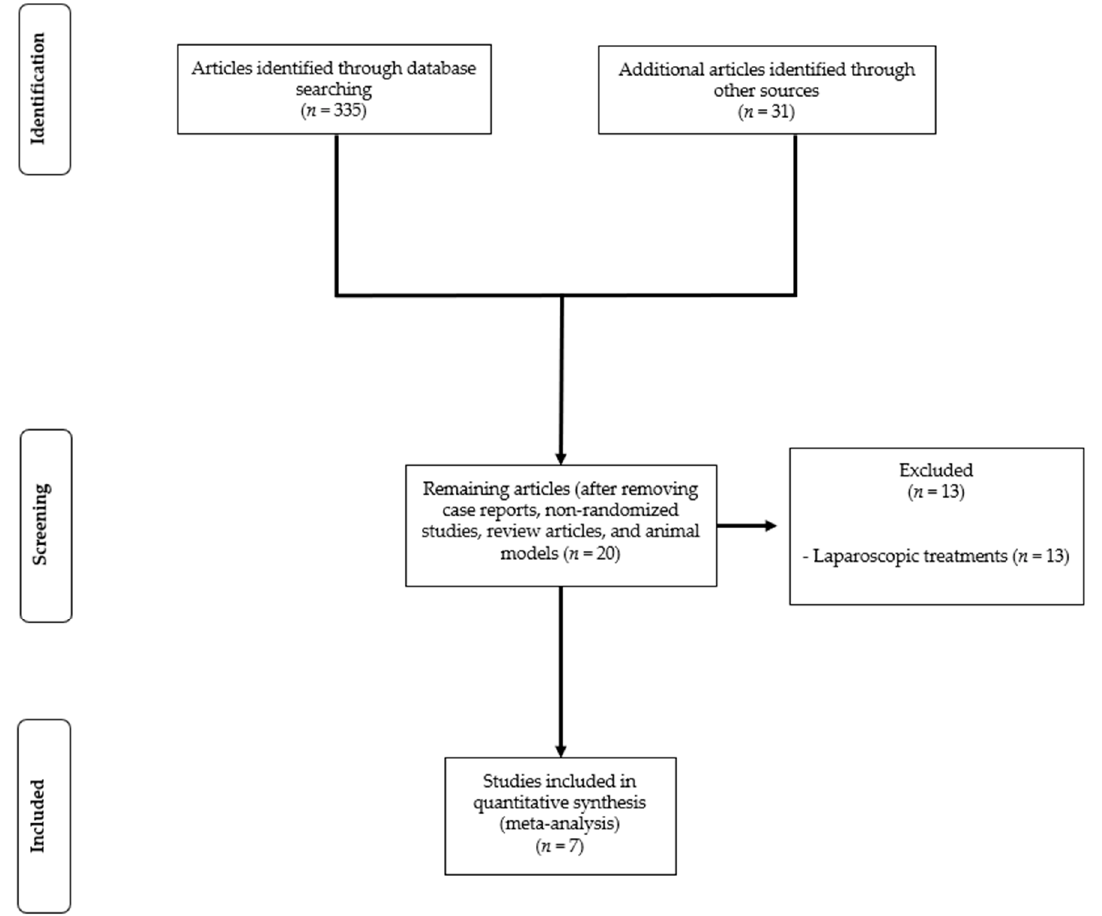
Figure 1. Flow chart of the search strategy.